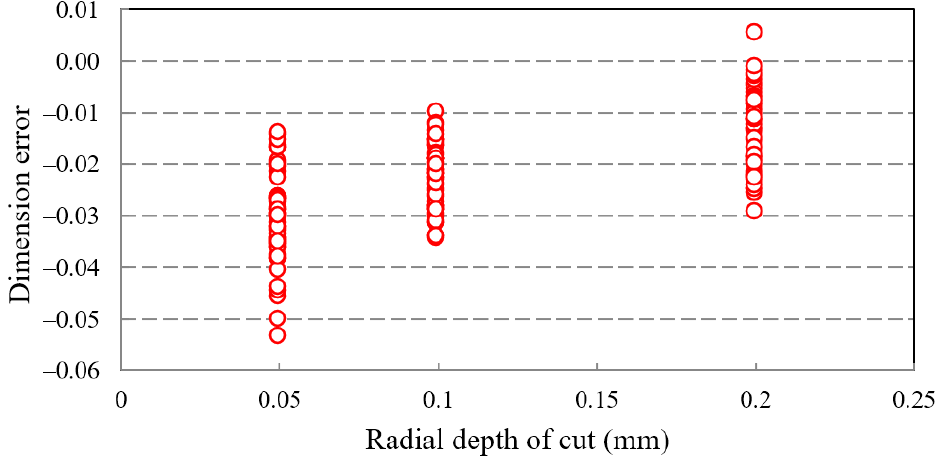
Figure 19. Distribution graph of dimensional accuracy in terms of radial depth of